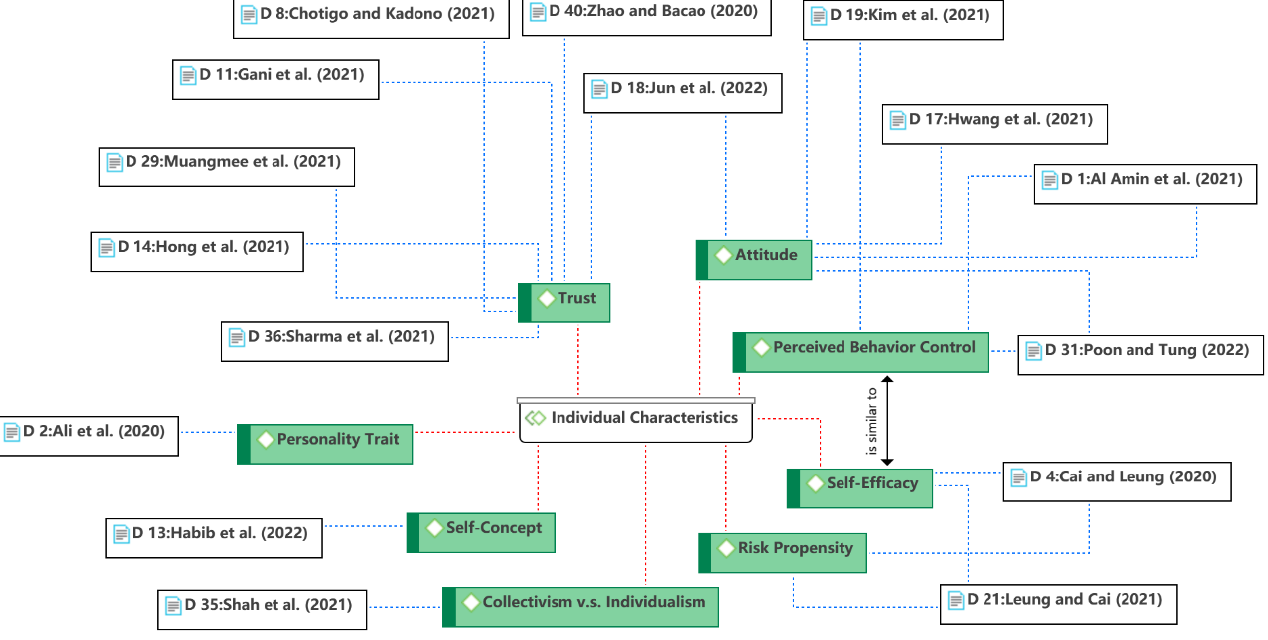
Figure 8. Theme 4: individual characteristics [6,12,23,26,35 – 37,39,40,43,46,50,52,56,58,59].